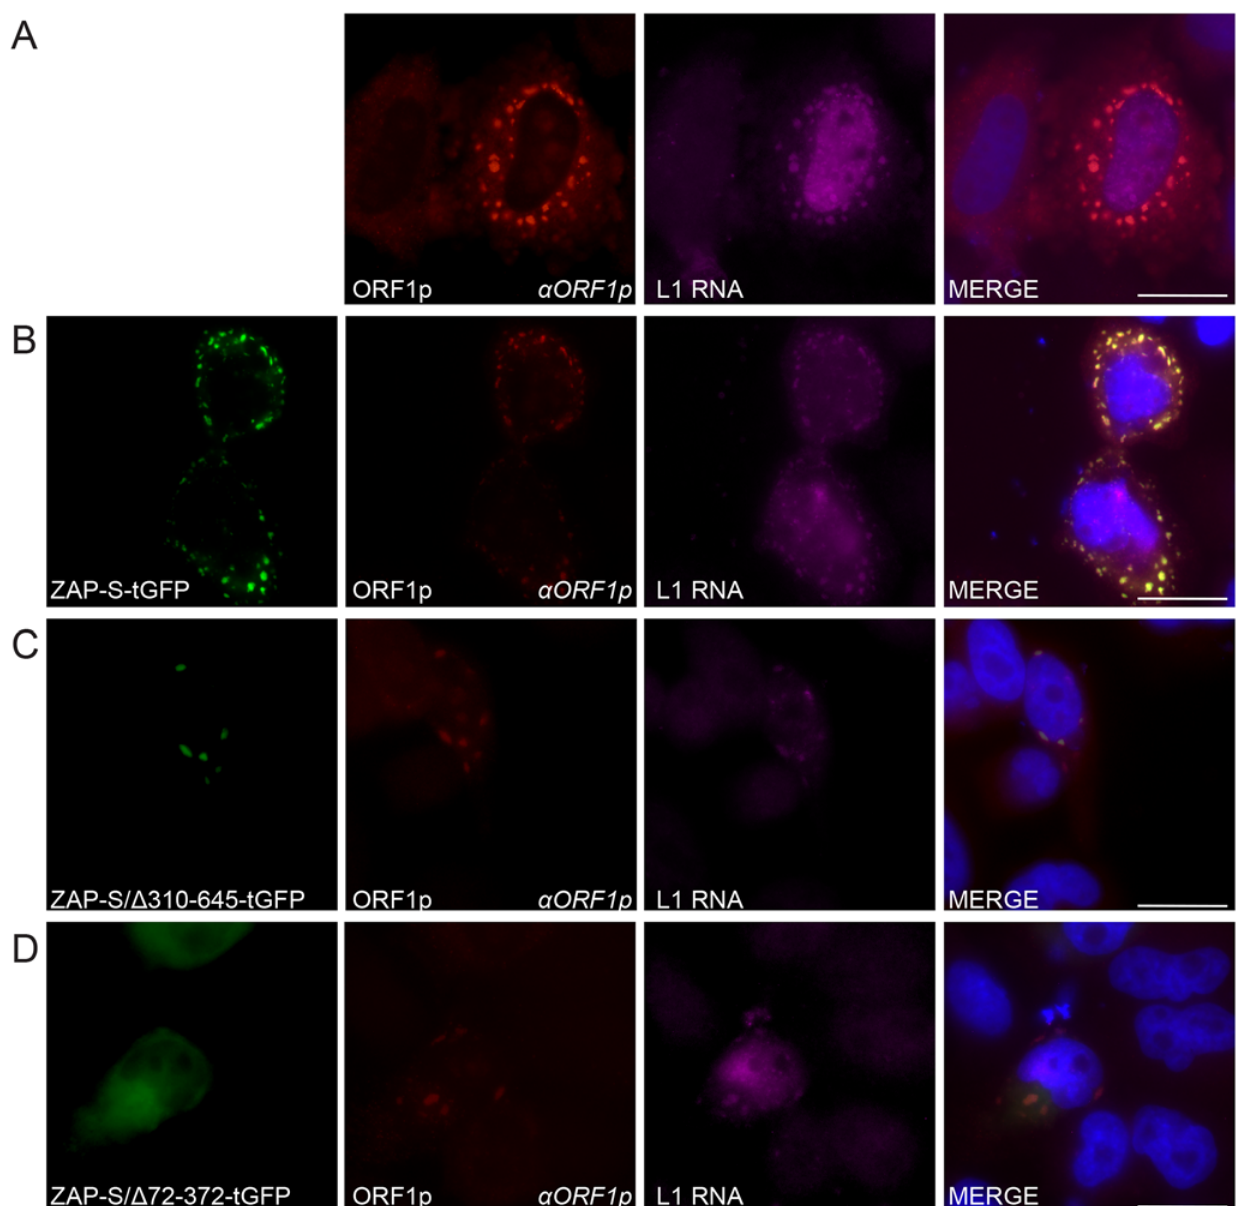
Fig 6. The co-localization of ZAP with L1 RNA and ORF1p in HeLa cells. (A) Co-localization of transfected L1 RNA and ORF1p : ORF1p (red) expressed from pJM101/L1.3 co-localizes with L1 RNA (magenta). (B) Co-localization of transfected L1 RNA and ORF1p with transfected ZAP-S-tGFP in cytoplasmic foci : ORF1p (red) and L1 RNA (magenta) expressed from pJM101/L1.3 co-localize with ZAP-S-tGFP (green). (C-D) The ZAP-S zinc-finger domain is necessary for co-localization with ORF1p : ORF1p (red) and L1 RNA (magenta) expressed from pJM101/L1.3 co-localize with ZAP-S/ Δ 310-645-tGFP (green) (panel C). ZAP-S/ Δ 72-372-tGFP (green) diffusely distributes throughout the cytoplasm, while ORF1p (red) expressed from pJM101/L1.3 forms cytoplasmic foci with L1 RNA (magenta) (panel D). The right-most image of each panel represents a merged image. The name of the protein or RNA is indicated at the bottom left, and the name of the primary antibody used ( italicized ) is annotated at the bottom right of each image. Nuclei were stained with DAPI (blue) and the scale bar represents 25 μ M. Experiments were repeated three times with similar results.